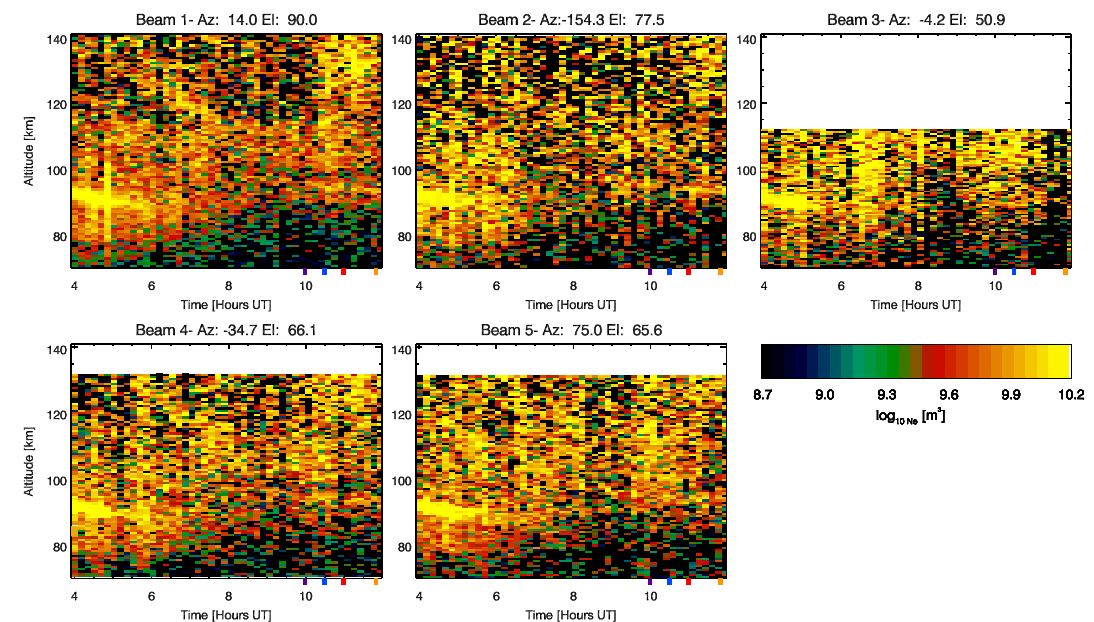
Figure 5. Electron densities observed with PFISR. The times of the four rocket launches (41.076, 78, 79, 77) are marked with the colored ticks at the